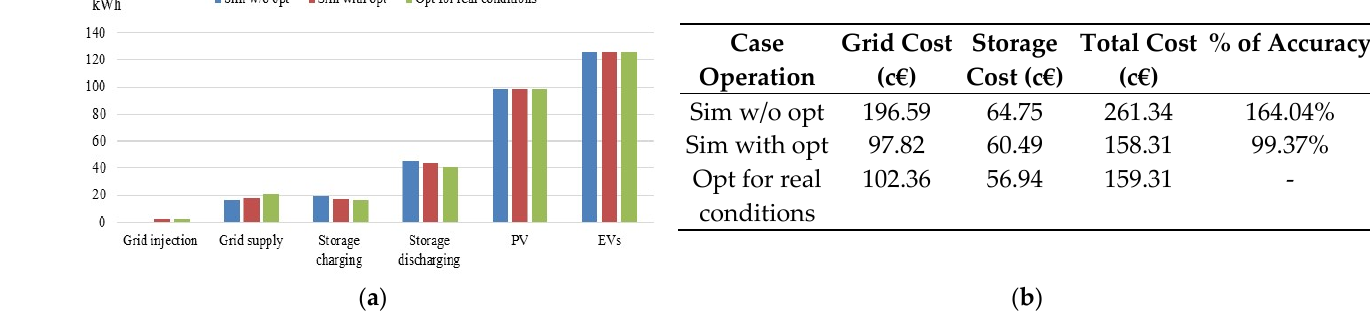
Figure 12. ( a ) Energy system distribution and ( b ) energy system cost—case 2.